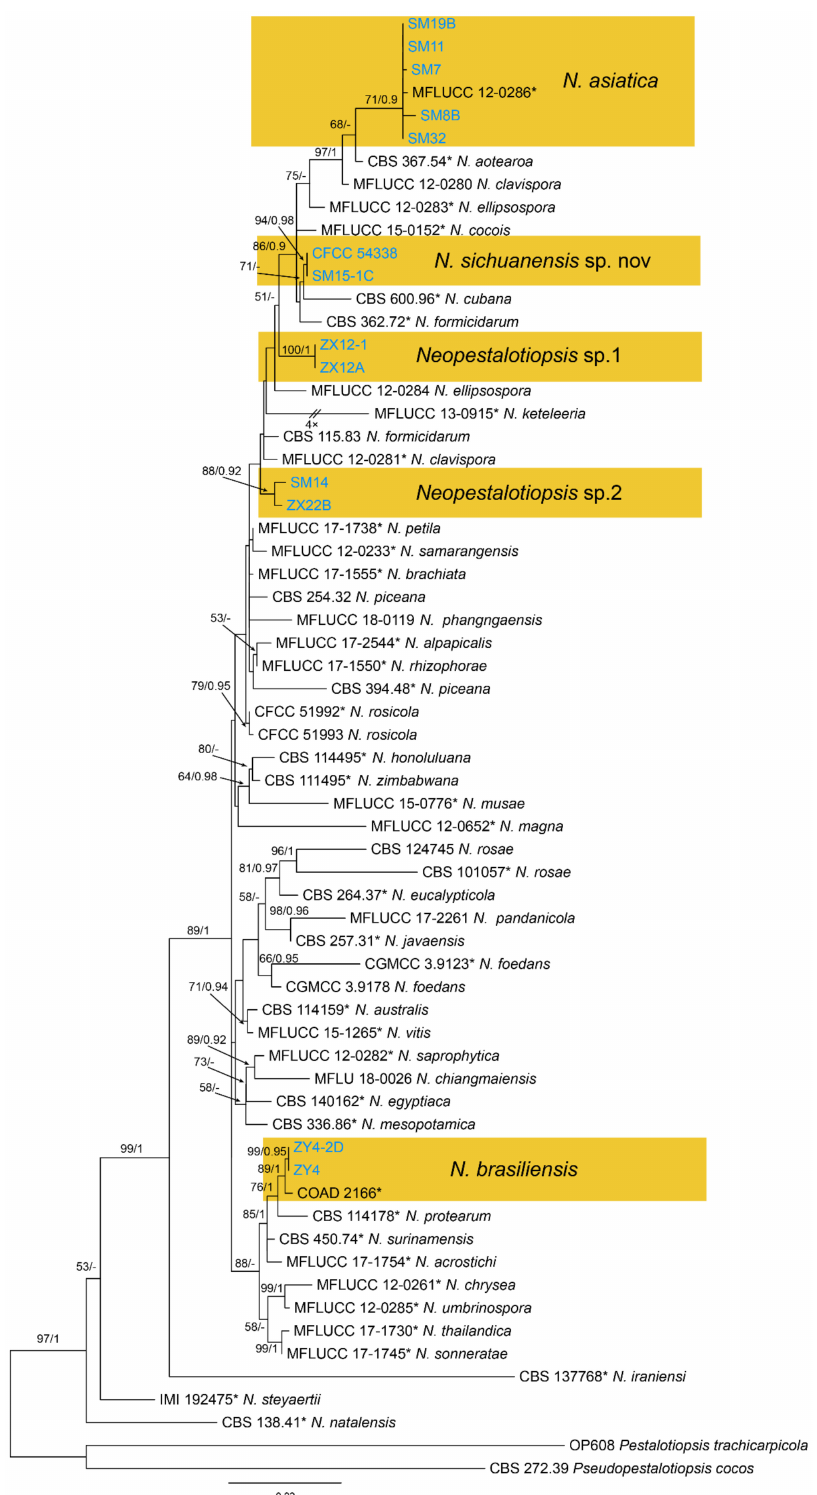
Figure 13. Phylogram generated from RAxML analysis based on combined ITS tef1 and tub2 sequence data of Neopestalotiopsis isolates. The tree was rooted to Pestalotiopsis trachicarpicola (OP608) and Pseudopestalotiopsis cocos (CBS 272.39). The scale bar indicates 0.02 nucleotide changes per site. Isolates from this study are marked in blue, ex-type strains are marked with *, and the identified species are marked in